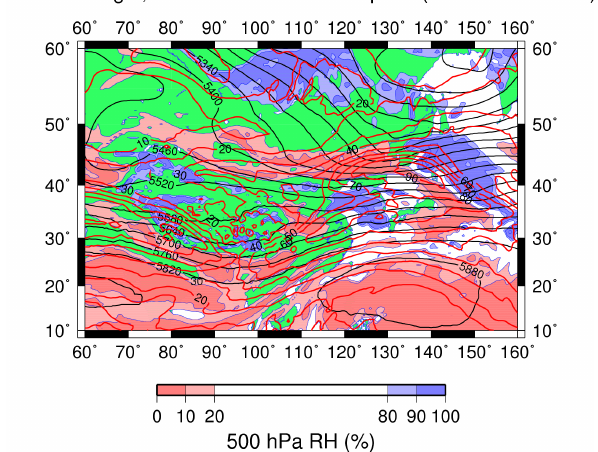
Fig. 9. Upper air field over the East Asia Region. Black solid lines indicate the geopotential height at 500hPa. Red solid lines indicate the wind speed at the 250-hPa isobar. Colour bars show the relative humidity at the 500-hPa